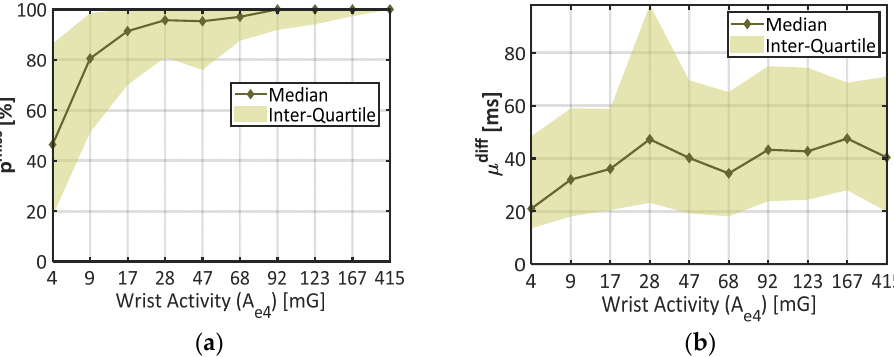
Figure 4. Statistics on IBI estimation quality through distinct levels of wrist activity. ( a ) Proportion of missed beats (p miss ) against wrist activity (A e4 ); ( b ) Misestimation degree (µ diff ) against wrist activity. The X-Axis represents each decile of A e4 in the dataset. Plain lines stand for the median error at each decile of activity, and colored areas materialize the interquartile range.